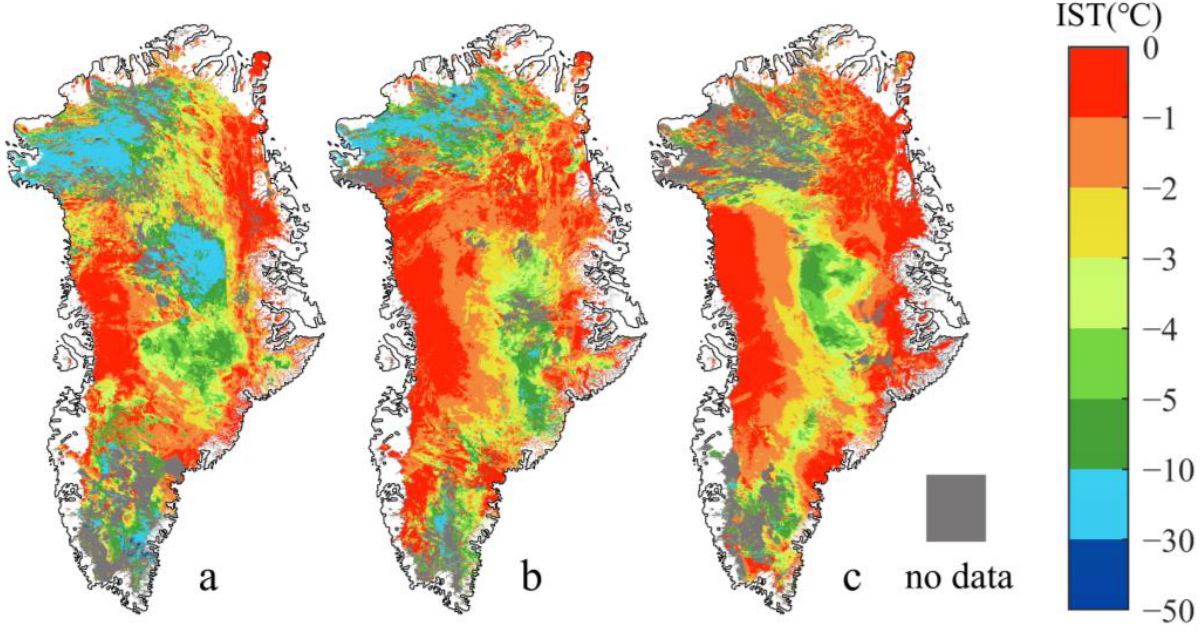
Figure 8. MODIS IST maps for ( a ): 11 July, ( b ): 12 July, and ( c ): 13 July 2012. The IST grid that is under cloud cover or has no data is considered as no data.